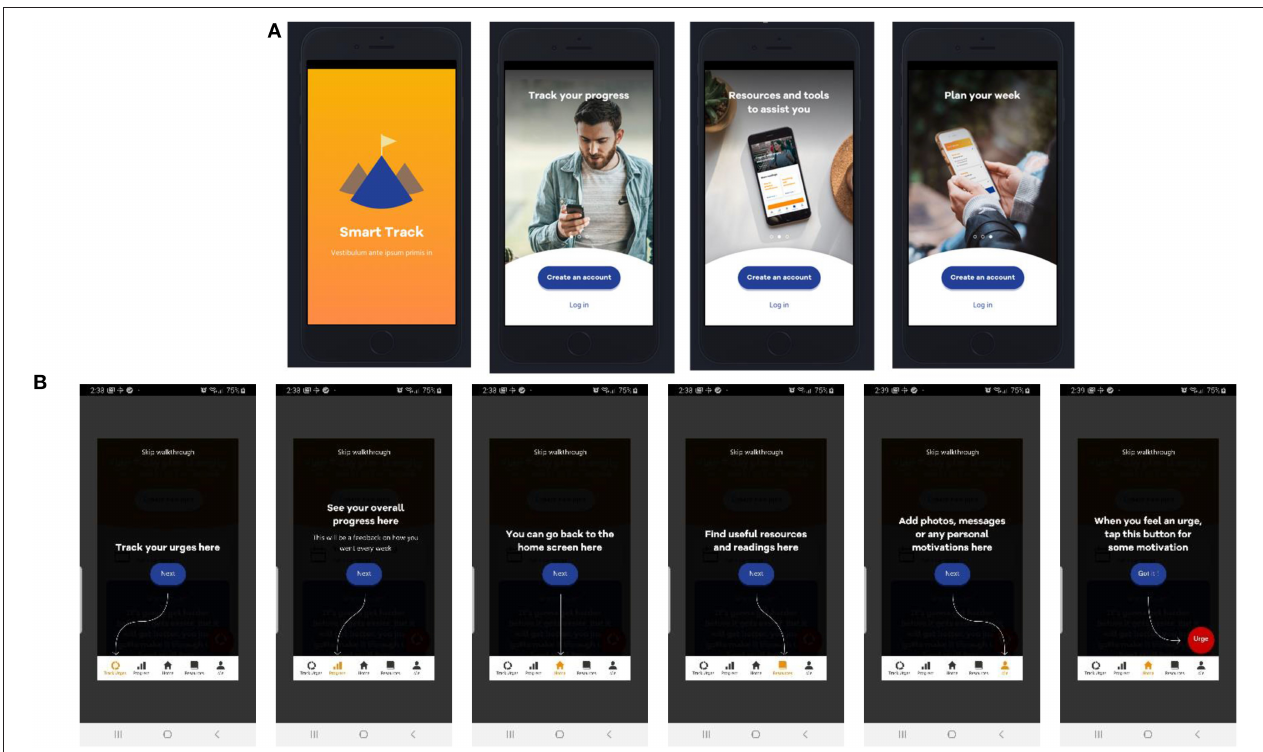
FIGURE 4 | (A) SMART Track Overview and (B) Participant “Walk Through”.